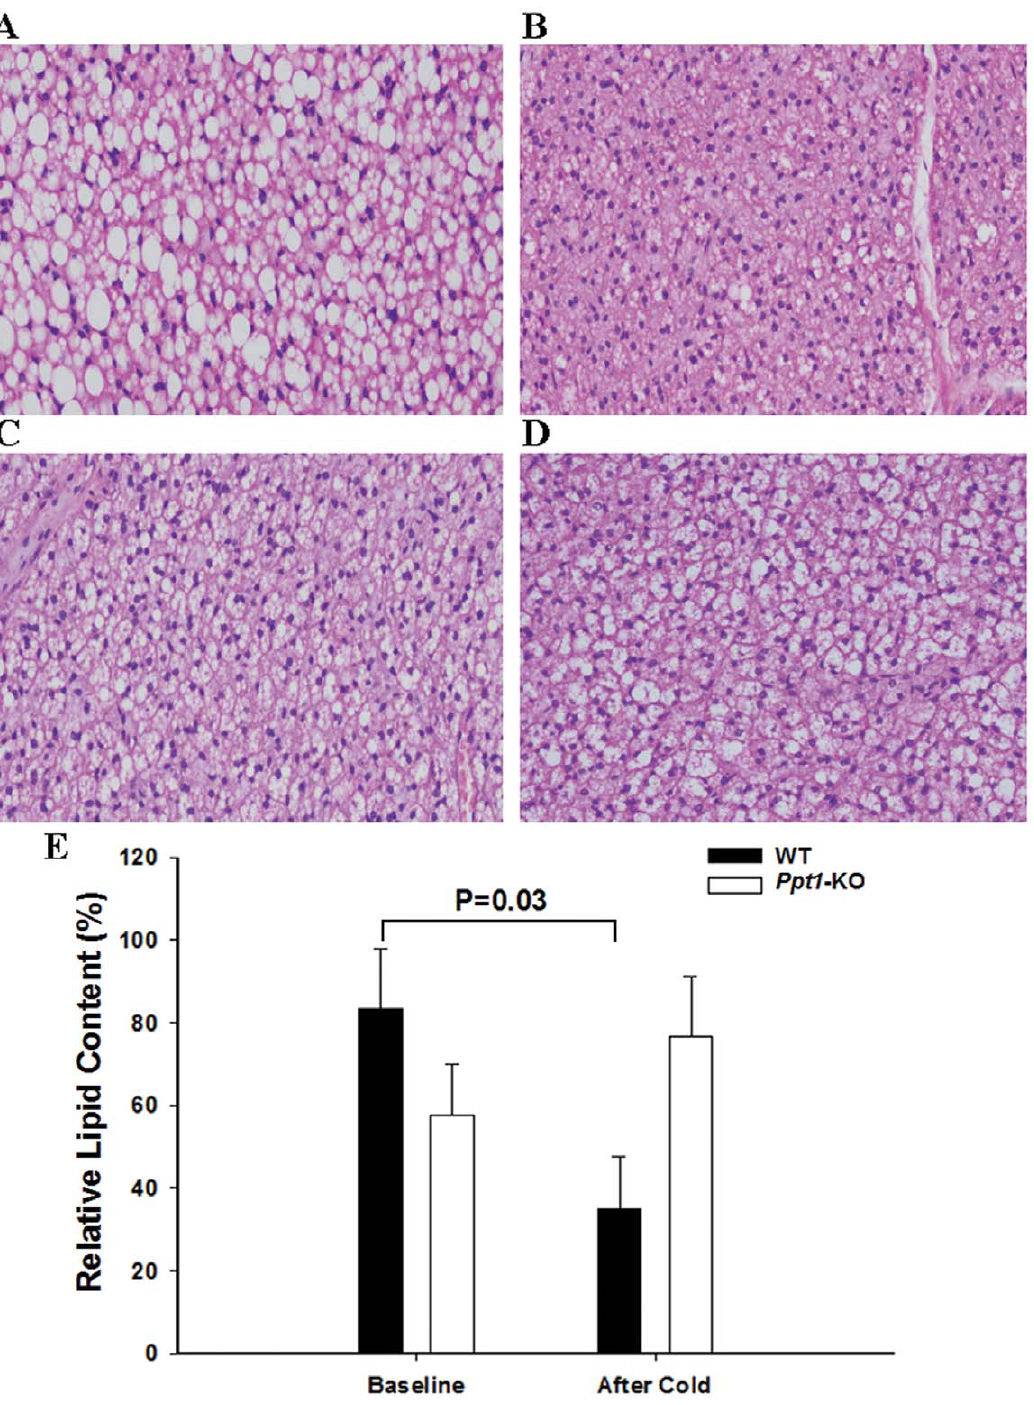
Figure 5. Fat content in brown adipose tissue during basal conditions and acute cold exposure. Representative 20 6 H&E staining of brown adipose tissue obtained before (A and C) and after (B and D) a 3-h acute cold exposure in Ppt1- KO (C and D) and wild-type (A and B) mice. E. Relative fat content in brown adipose tissue before and after a 3 h acute cold exposure in Ppt1- KO and wild-type mice. N=3 2 5 in each group.